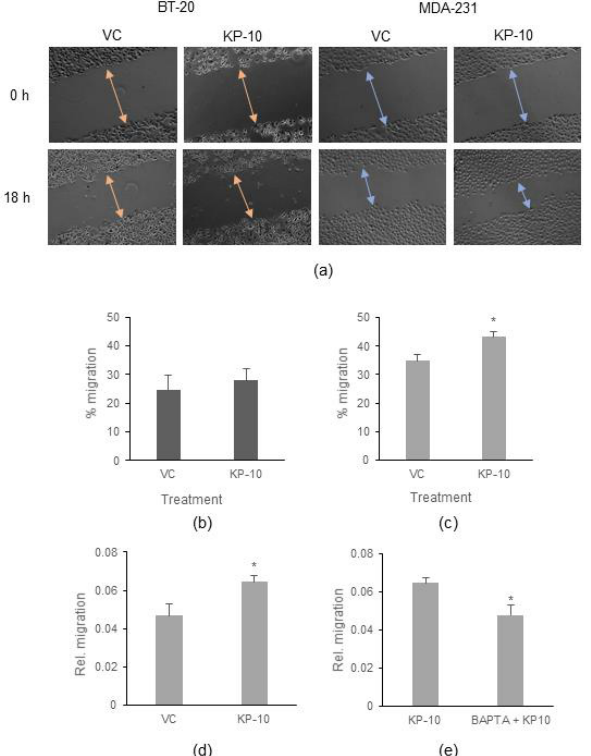
Figure 3. KP-10 increases migration in a calcium dependent manner only in MDA-MB-231 cells. ( a – c ) Cell migration was assessed in serum-free culture conditions via scratch assay with BT-20 and MDA- MB-231 cells treated with of 100 nM KP-10 or the vehicle control (VC). ( a ) Phase-contrast images were generated with a 5 × magnification at 0 h and 18 h after stimulation. Scale bar, 100 µ m. ( b ) Quantification (mean ± SEM of three independent experiments) of percentage wound closure in BT-20 cells. No significant difference ( p > 0.05, Student’s t -test) between VC and KP-10 treatments. ( c ) Quantification (mean ± SEM of three independent experiments) of percentage wound closure in MDA-MB-231 cells. * p < 0.05 (Student’s t -test) for comparison of VC and KP-10 treatments. ( d ) Cell migration was measured in MDA-MB-231 cells using an Oris™ migration assay kit under serum-free culture conditions 18 h following stimulation with 100 nM KP-10 or the vehicle control (VC). Graph depicts quantification (mean ± SEM of three independent experiments) of relative migration. * p < 0.05 (Student’s t -test) for comparison of VC and KP-10 treatments. ( e ) Cell migration was measured in MDA-MB-231 cells using an Oris™ migration assay kit under serum-free culture conditions for 18 h following stimulation with 100 nM KP-10 in the presence and absence of 10 µ M BAPTA-AM. The graph depicts quantification (mean ± SEM) of three independent experiments. * p < 0.05 (Student’s t -test) for comparison of presence and absence of